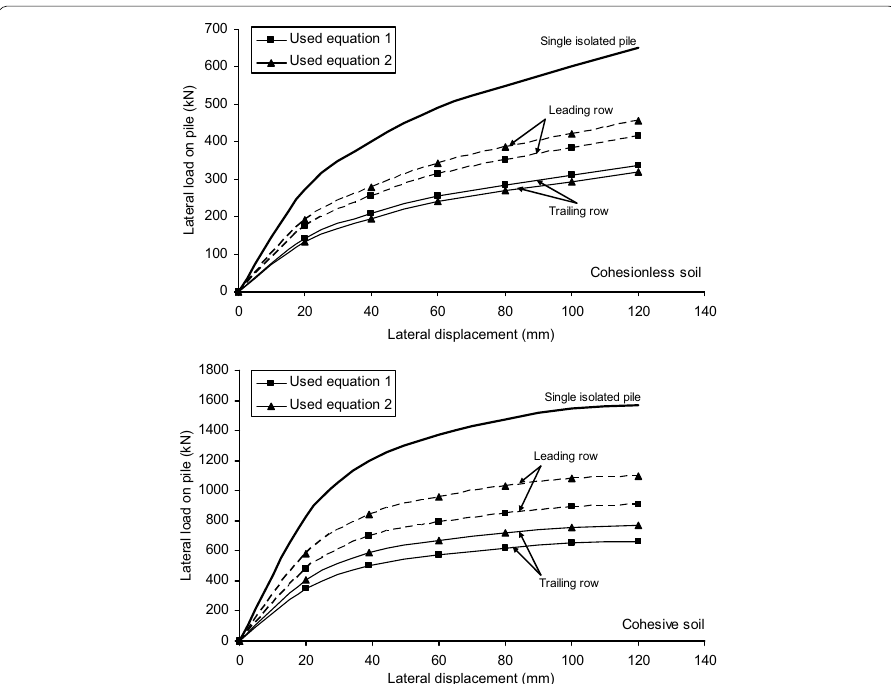
Fig. 11 Load‑deflection curves obtained from the example of pile group with predicted computed from improved p‑multiplier